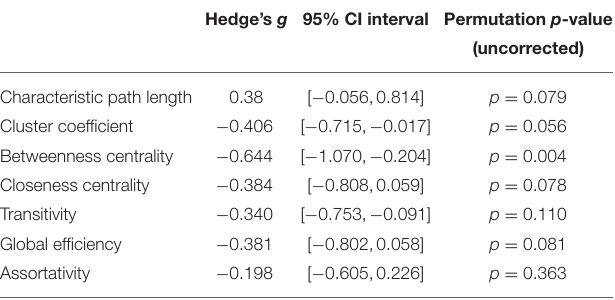
TABLE 2 | Permutation test statistics for the SCZ group (sample size n = 43).